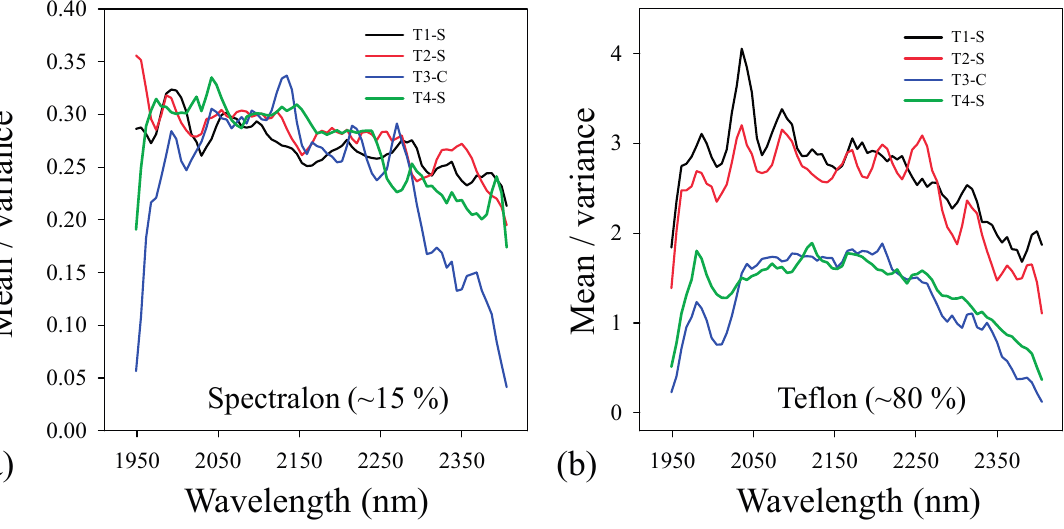
Figure 2. Mean pixel values ( n = 120) over homogenous dark and bright targets, divided by their variance as a measure of the relative amount of noise across replicate images: ( a ) data from 15% reflective Spectralon; ( b ) data from ~80% reflective Teflon. Larger and smaller values indicate, respectively, that noise comprised a smaller or larger component of the overall signal.